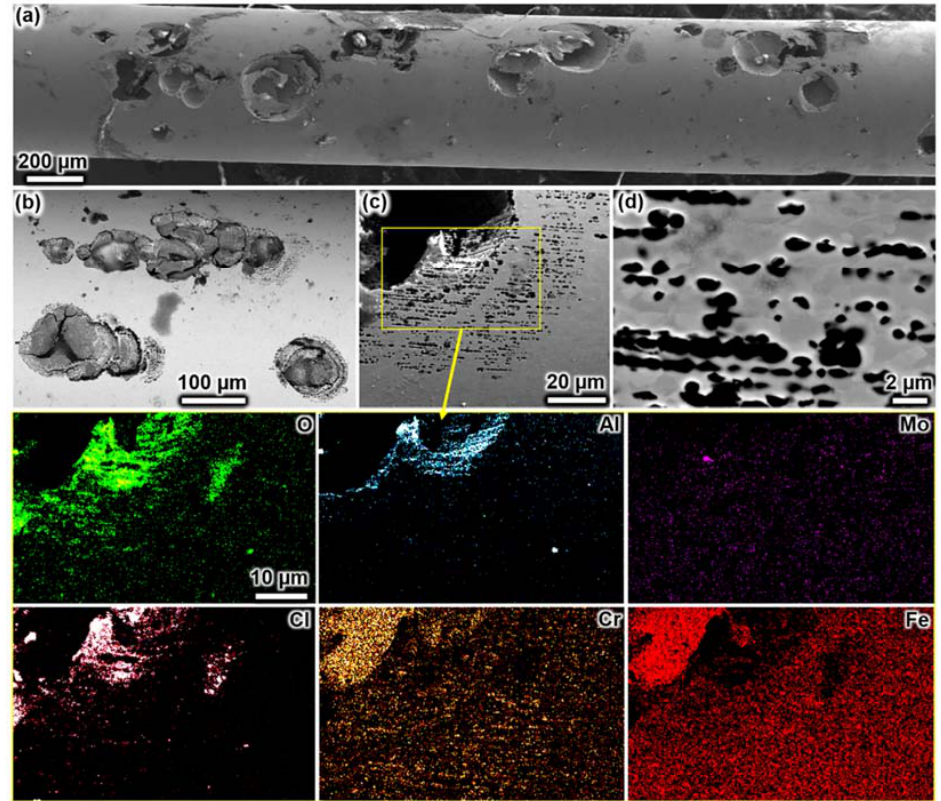
Figure 4. SEM images showing the corrosion morphology after potentiostatic polarisation in 1 M NaCl at 900 mV vs. Ag/AgCl at pH 3 and 60 °C (see Figure 3). The sample underwent extensive pitting corrosion. The micrograph in ( a ) shows numerous corrosion pits with partially collapsed lacy covers (SE image), ( b ) magnified view (BSE image), ( c ) zoomed view near the pit mouth on a perforated cover remnant, ( d ) magnified view of the perforated cover. The chemical maps depict the detected elements in the highlighted region in ( c ).